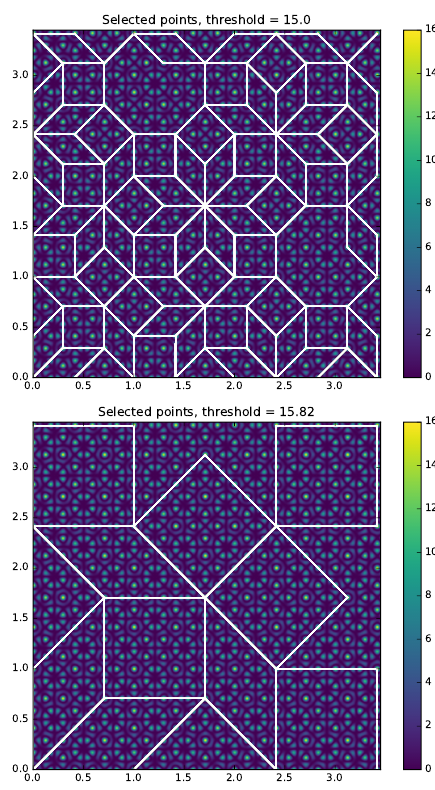
Figure 2. Intensity plot showing the profile of the optical potential I ( (cid:126) r ) in the plane. On this are superposed the tilings obtained by connecting occupied sites, for intensity cut-offs I c / I 0 = 10.8,15.0 and